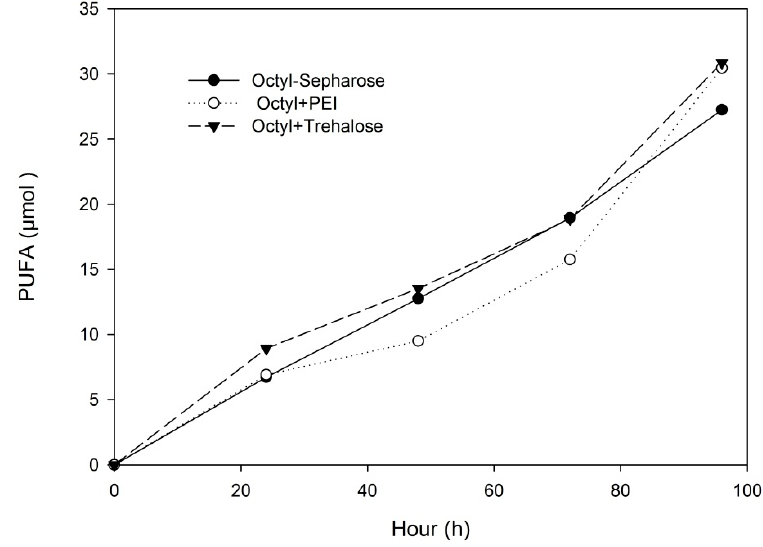
Figure 2. Release rates of PUFA (EPA + DHA). Reaction was carried out in an aqueous/organic